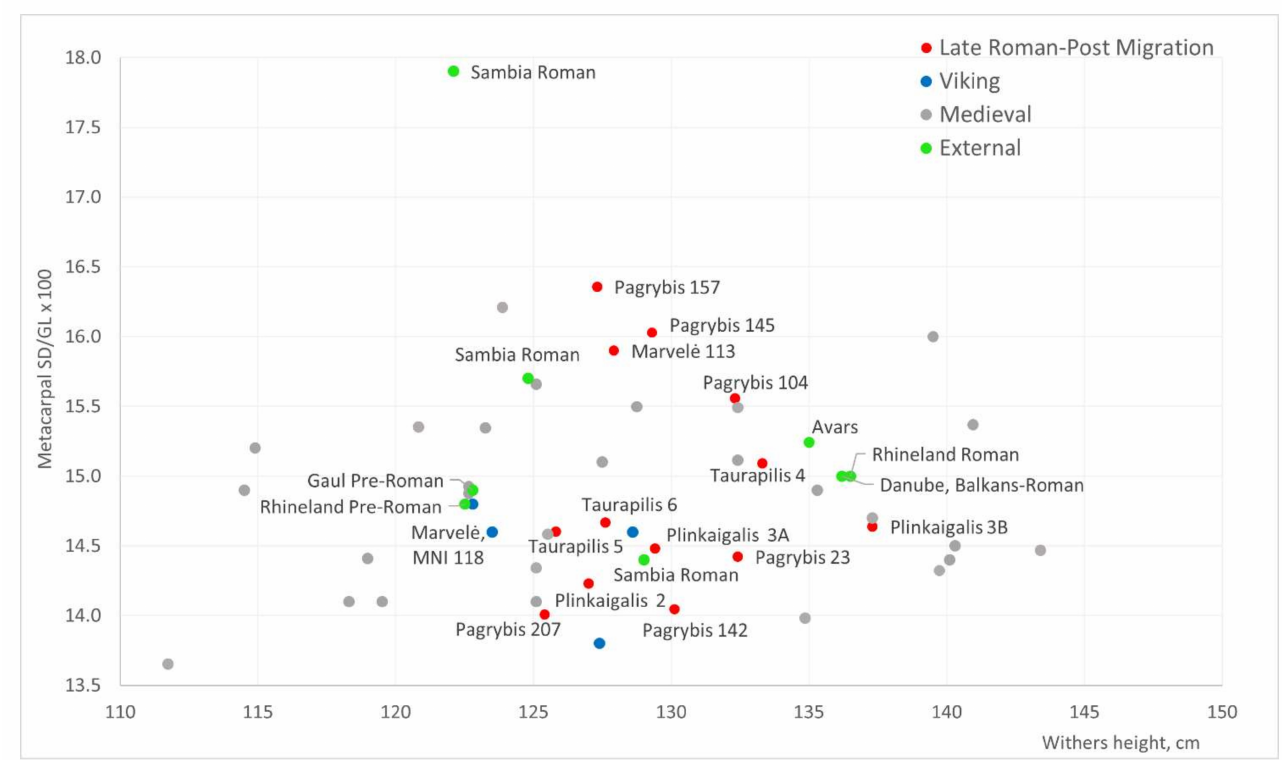
Figure 9. Withers height and metacarpal index (SD/GL × 100) of 3rd–14th C AD Lithuanian and horses from external